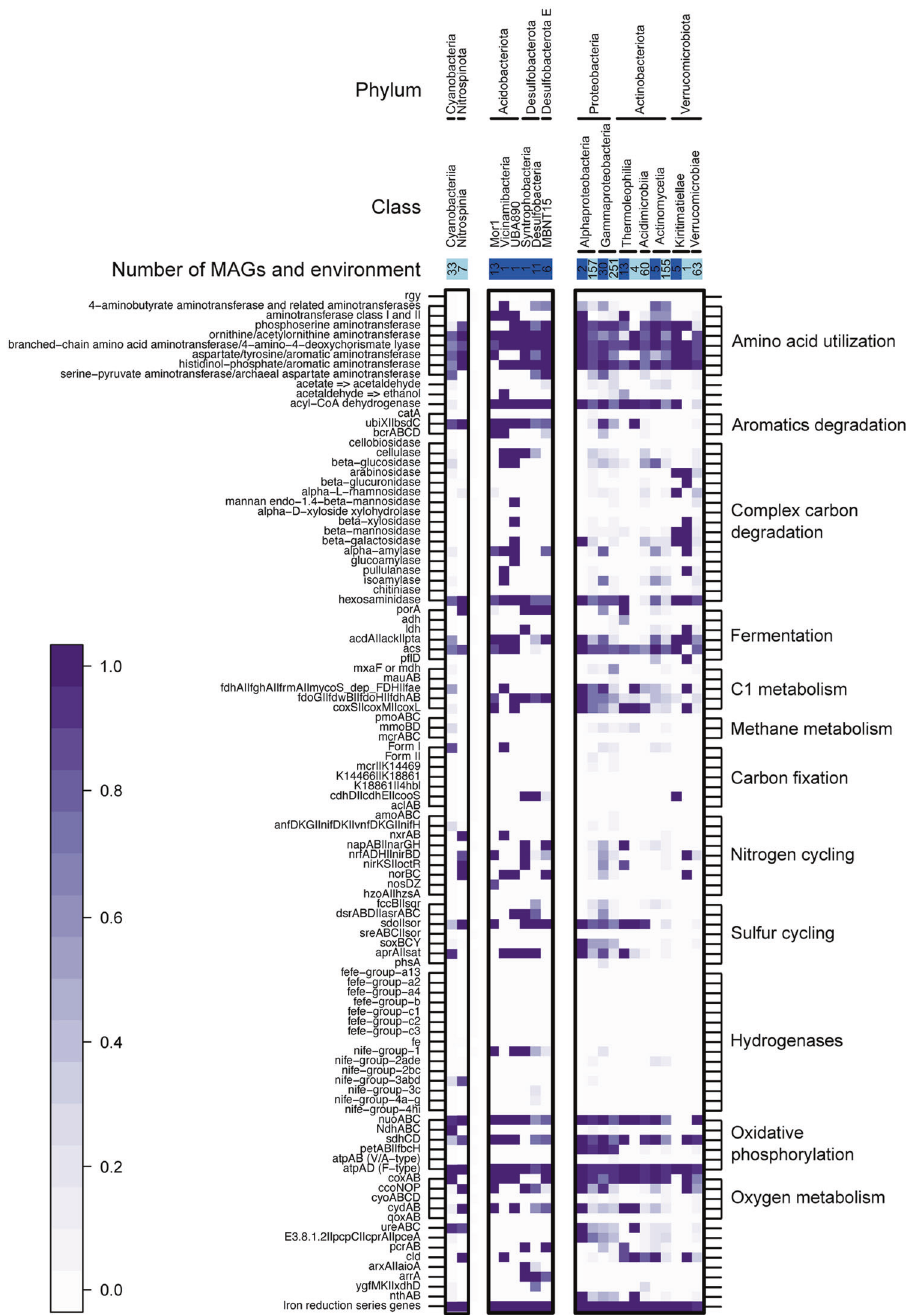
inner numbers indicate the number of MAGs per category. In the heatmap, white squares indicate absence of a given gene in all MAGs, and the darkest purple indicates presence in all of them (gradient scale on the bottom-left part of the fi gure for